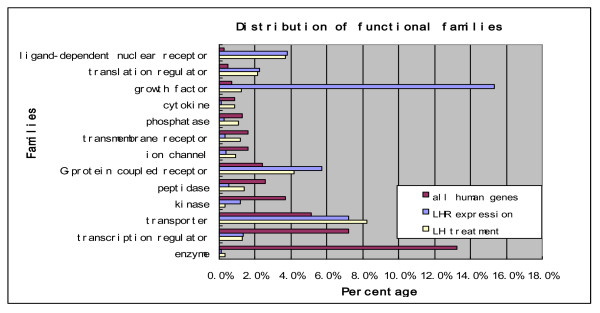
Distributions of the 2,373 differentially expressed genes in SKOV-3 cells across IPA functional families. Each blue bar represents the percentage of differentially expressed genes associated with LHR expression; each yellow bar represents the percentage of differentially expressed genes upon incubation with LH; each red bar is the percentage of all human genes. The x-axis represents the percentage and the y-axis denotes functional families.